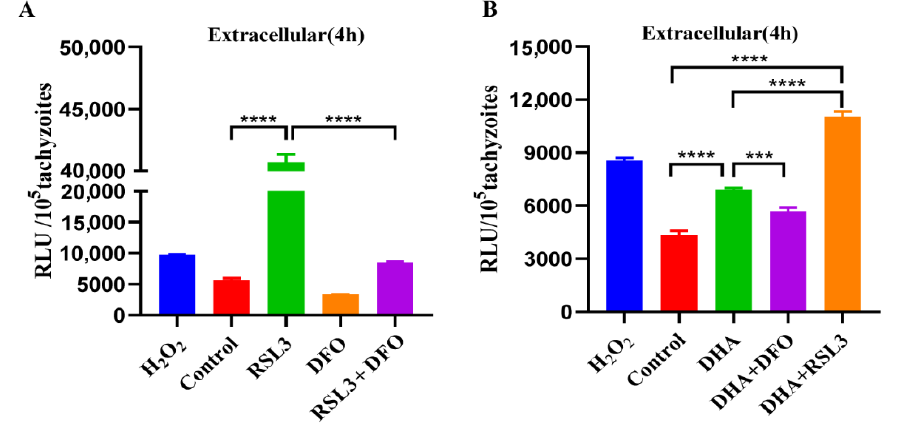
Figure 5. Effect of the ferroptosis inducer and inhibitor on ROS levels of T. gondii. ( A ) Effects of ferroptosis inducer RSL3 and inhibitor DFO on ROS of T. gondii . Fresh tachyzoites were incubated at 37 ◦ C and exposed to DMSO, 3 µ M RSL3 (4 × EC 50 ), or 3 µ M RSL3 + 80 µ M DFO for 4 h. Then, the fluorescence intensity of ROS was detected using DCFDA. ( B ) The effect of DHA combined with the ferroptosis inducer or inhibitor on the ROS level of T. gondii . The mean fluorescence intensity of ROS treated with compounds DHA, DHA + DFO, and DHA + RSL3 was detected. Experiments were performed in triplicate. Statistical analysis used Student’s t -tests (*** p < 0.001, and **** p < 0.0001).